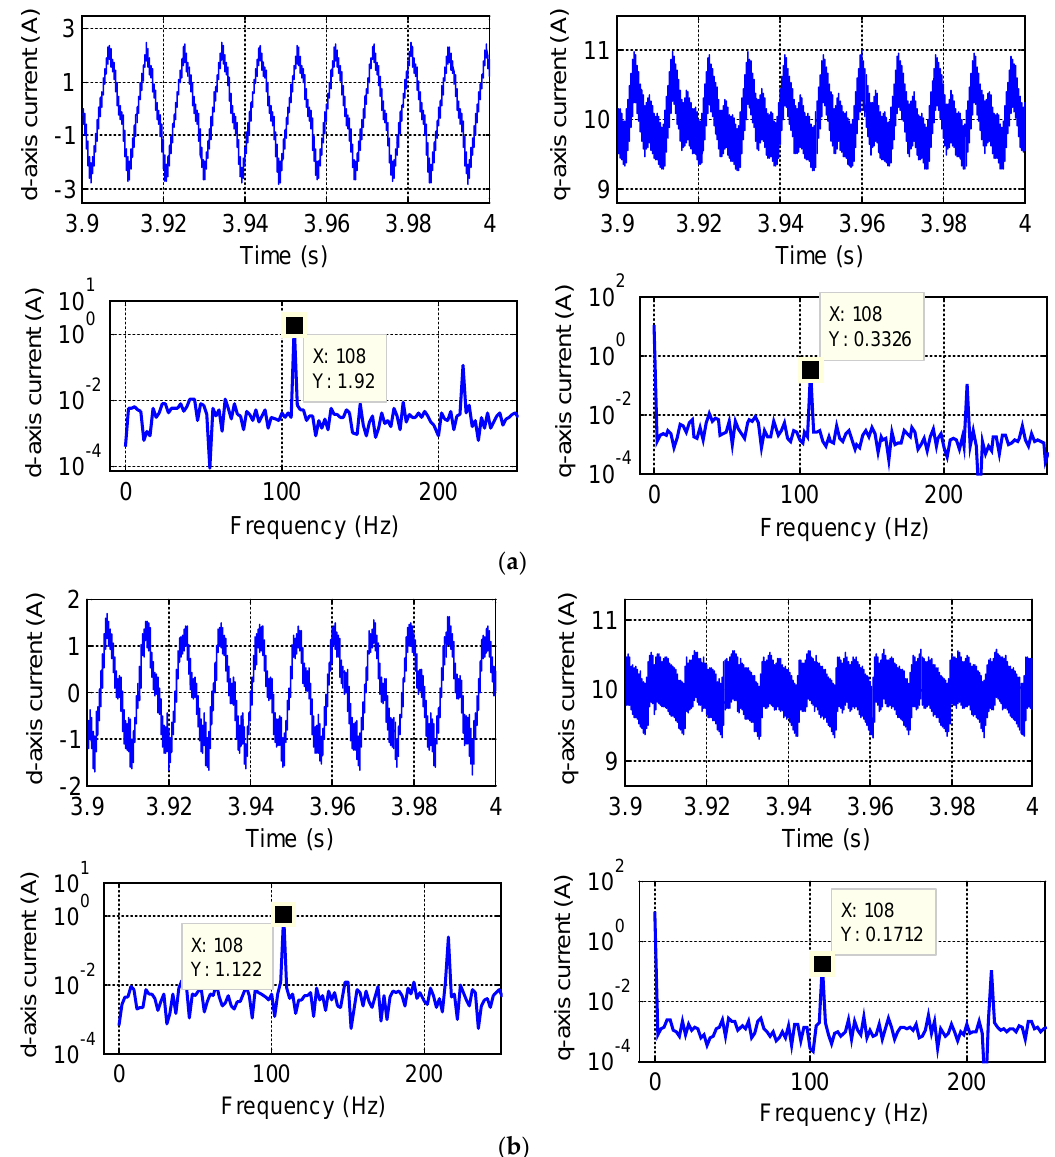
Figure 14. Waveforms and Fast Fourier Transform (FFT) results of d-axis and q-axis currents at 270